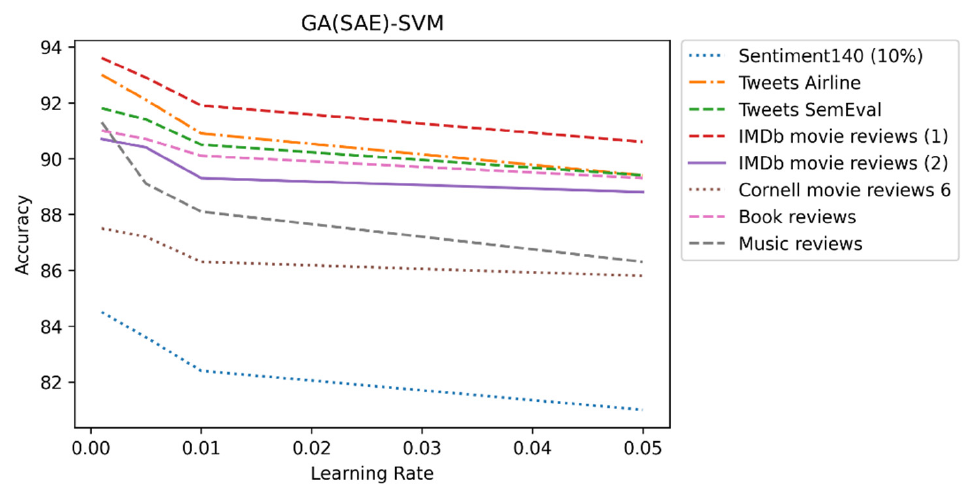
Figure 6. Learning rate impact of GA(SAE)-SVM on all datasets.